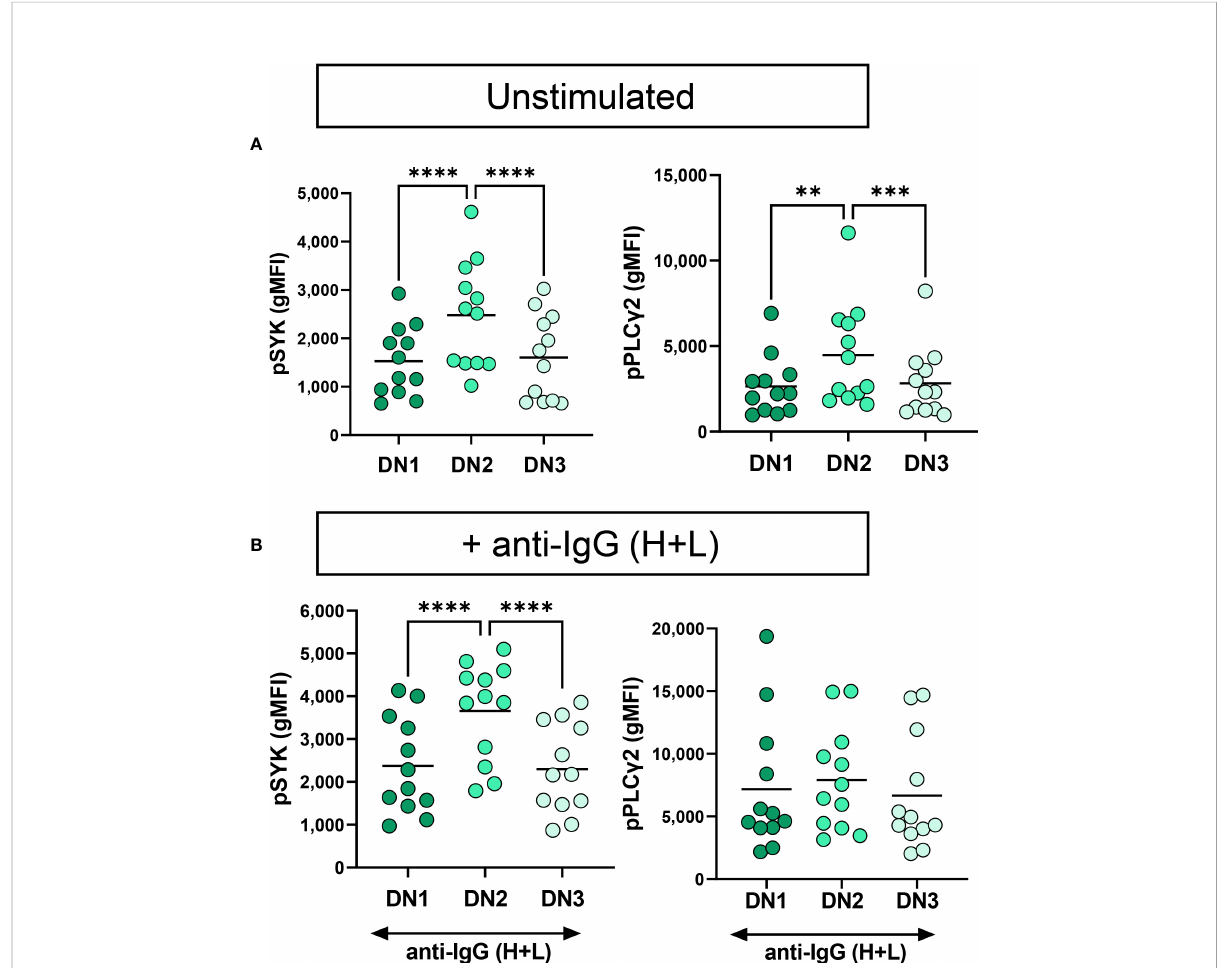
FIGURE 7 Functional comparison of DN1, DN2 and DN3 cells in severe SARS-CoV-2 infection. (A) Quanti fi cation of expression level of pSYK or pPLC g 2 on DN1, DN2 or DN3 cells from individuals with severe SARS-CoV-2 infection (N=12) without (unstimulated) or (B) with stimulation by 10 m g/mL anti-IgG (H+L) F(ab ’ )2 for 5 min. Statistics. one-way ANOVA, **p < 0.01, ***p < 0.001, ****p <